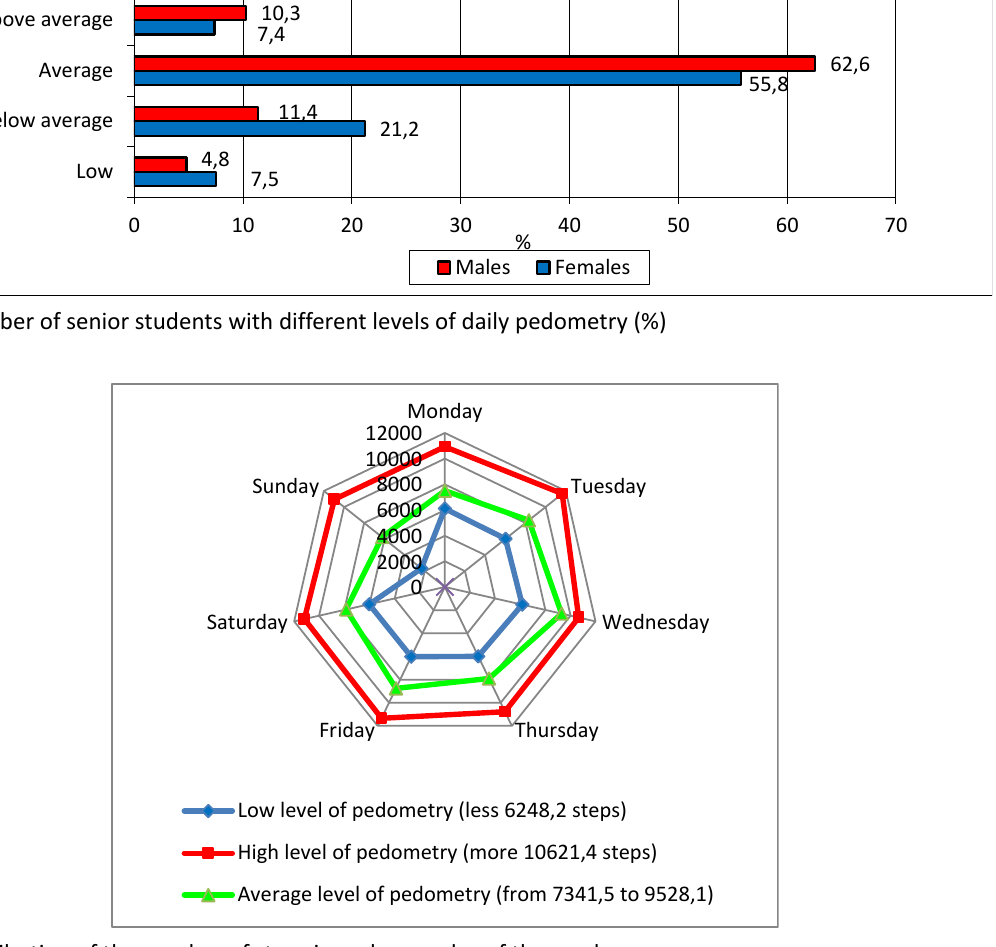
Figure 2. Distribution of the number of steps in males per day of the week